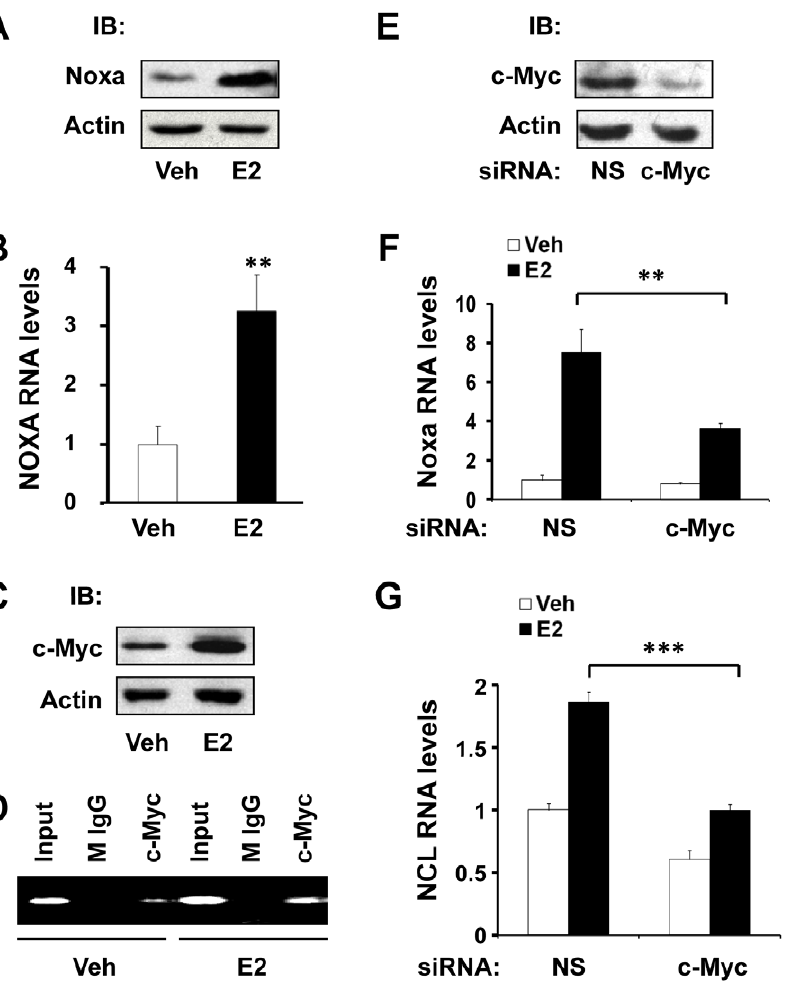
Figure 1. c-Myc mediates E2-induced Noxa transcription in human breast cancer cells. ( A–C ) MCF7 cells were treated with vehicle (veh) or E2 (10 nM) for 16 hr and then harvested for analysis of Noxa protein expression by western blotting (A), Noxa mRNA expression by qPCR (B), and c- Myc protein expression by western blotting (C). ( D ) MCF7 cells were treated with vehicle (veh) or E2 for 4 hr, and ChIP assays using anti-c-Myc antibody or normal mouse IgG (M IgG, antibody control) were performed to analyze the effect of E2 on the recruitment of c-Myc to the NOXA promoter. Immunoprecipitated ChIP DNA was analyzed by PCR using site-specific primers that amplify a region of the NOXA promoter that contains a c-Myc binding site at + 85 bp. ( E ) MCF7 cells were transfected with non-silencing control (NS) or c-Myc siRNA for 48 hr and then harvested for analysis of c-Myc protein levels by western blotting. ( F, G ) MCF7 cells were transfected with non-silencing control (NS) or c-Myc siRNA for 24 hr, followed by treatment with vehicle (veh) or E2 (10 nM) for 8 hr, and the relative mRNA expression levels of Noxa (F) and Ncl (G) were analyzed by qPCR. Graphical data points in B, F, and G are means 6 S.D. of three independent experiments (** P , 0.01, *** P , 0.001).